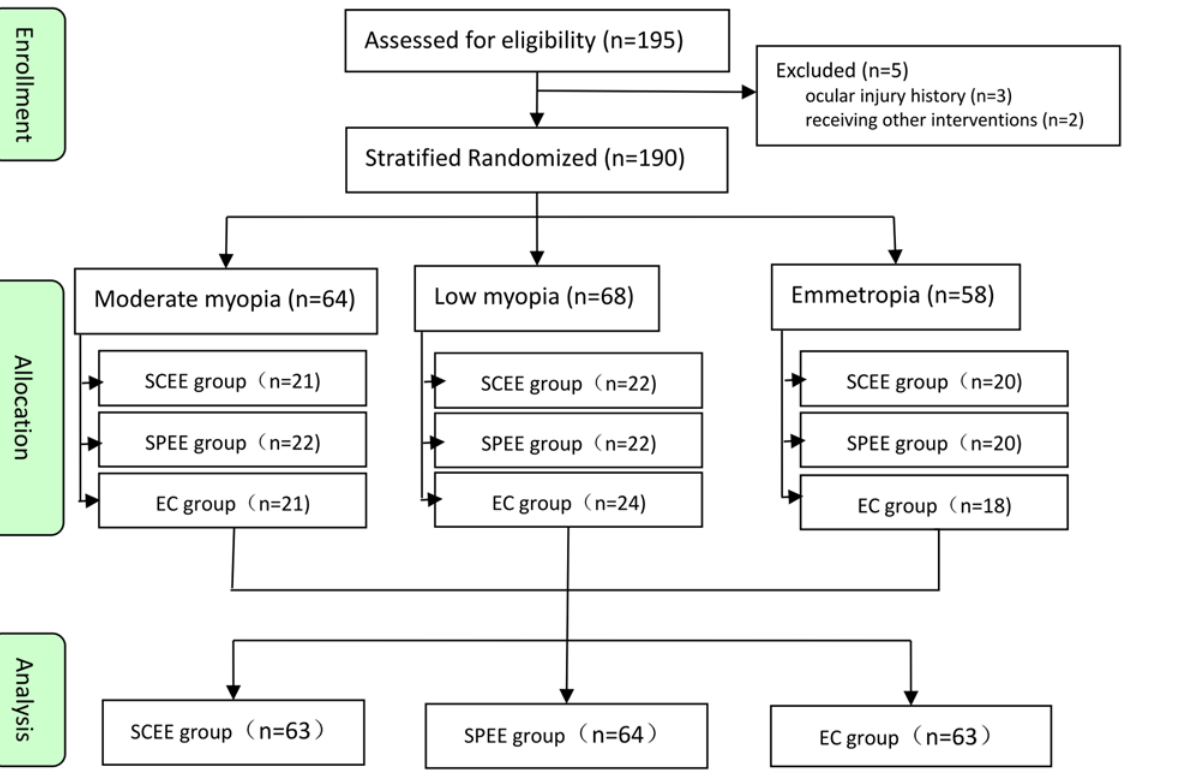
Fig 2. Flow of participant through